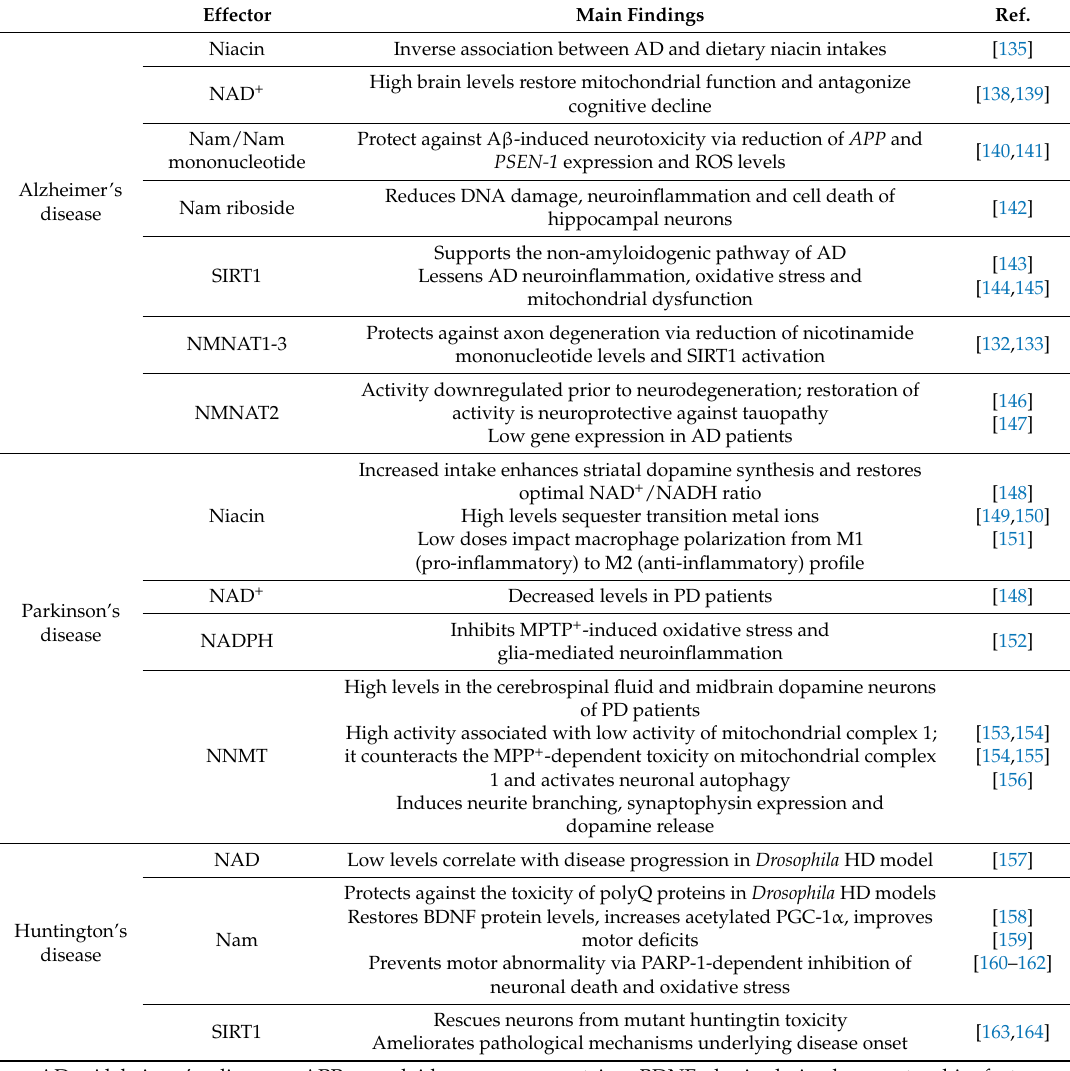
Table 1. Main findings on the role of niacin in